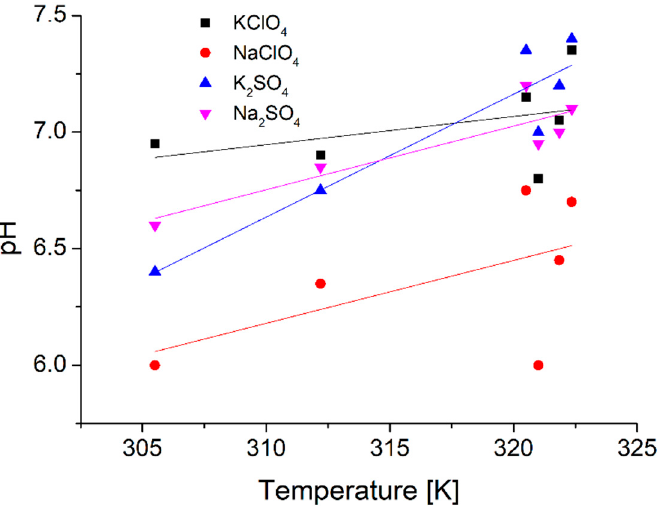
Figure 2. Temperature dependent pH measurements of 100 mM aqueous solutions of KClO 4 , NaClO 4 , K 2 SO 4 , and Na 2 SO 4 .